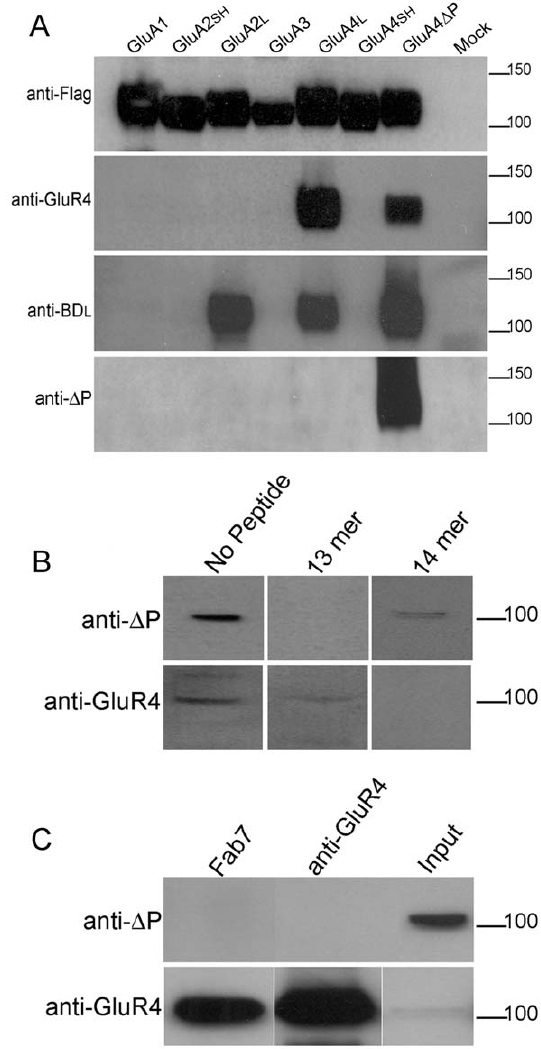
Figure 4. Analysis of AMPA receptors with an antibody specific for the exposed PDZ motif in GluA4 D P. (A) HEK293 cells expressing flag-tagged AMPA receptor subunits with all potential wild-type CTDs and the mutant GluA4 D P (indicated above) were immunoblotted with the antibodies indicated to the left. Short-tailed isoforms of GluA2 and GluA4 are indicated by SH. The initial antiserum, anti-BD L detects both A2 and A4 long tails isoforms and GluA4 D P. After the depletion procedure and purification, the anti- D P IgG only recognises GluA4 D P (lower panel). (B) Anti- D P IgG labels a single 100 kD band in rat cerebellar tissue; this is specifically blocked by preincubation with 13mer peptide (upper panels). Similarly anti-GluR4 IgG also labels a 100 kDa band. This labelling is blocked by pre- incubation with 14 mer peptide (lower panels). (C) Immunoprecipitation from rat cerebellar extract using independent AMPA receptor antibodies fails to bring down anti-D D P immunoreactivity (upper panel). An alternative antibody shows GluA4 levels were highly enriched in the immunoprecipitates (lower panel).